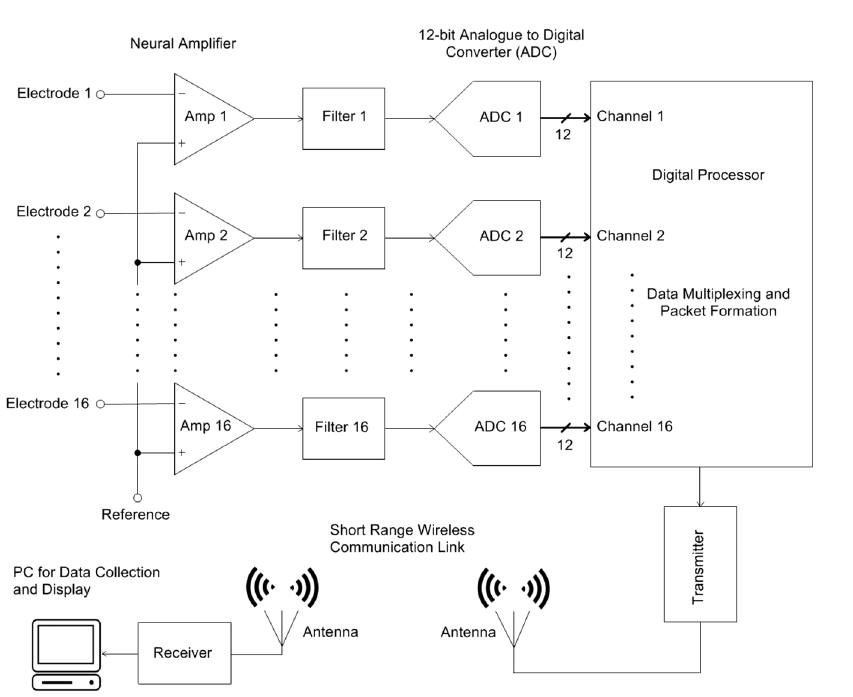
Figure 1. Circuit block diagram of the TaiNi